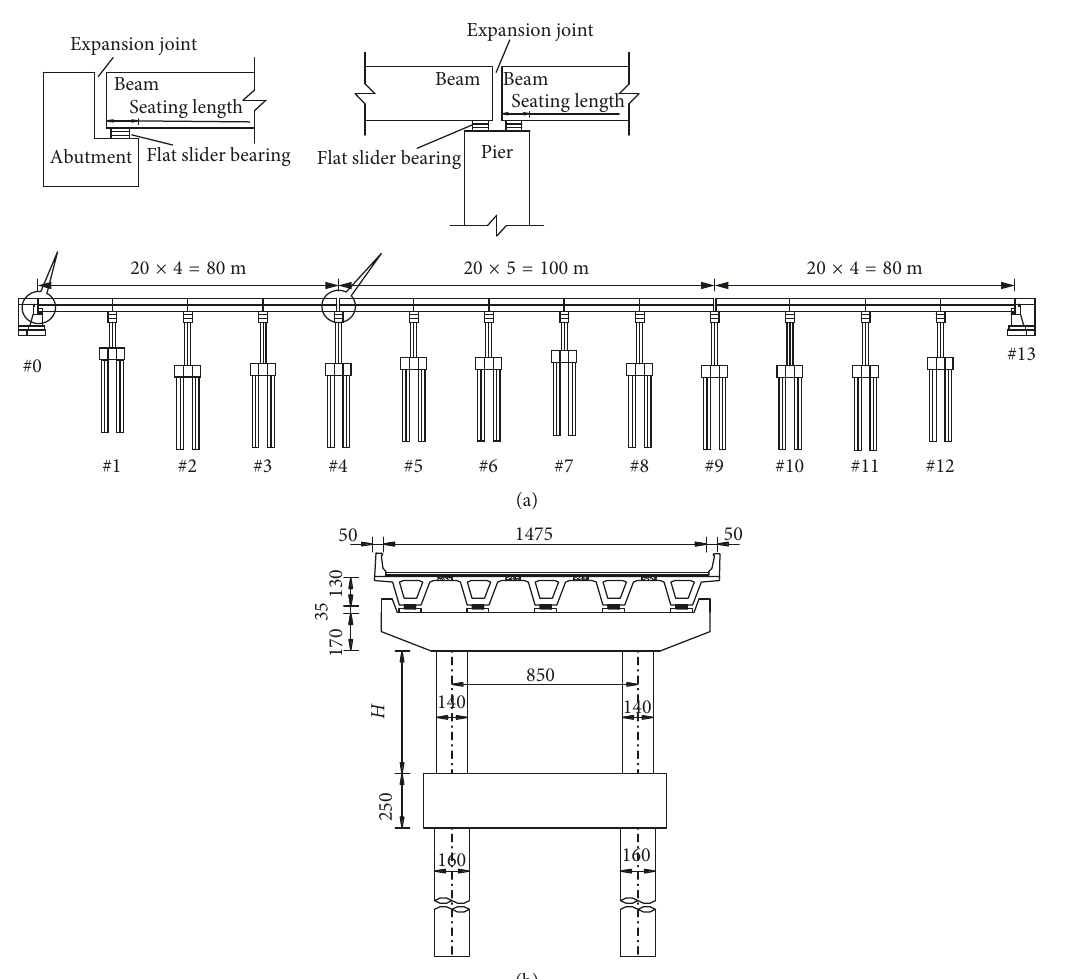
Figure 1: Elevation and transverse section of the bridges. (a) Elevation (unit: cm). (b) Transverse section (unit: